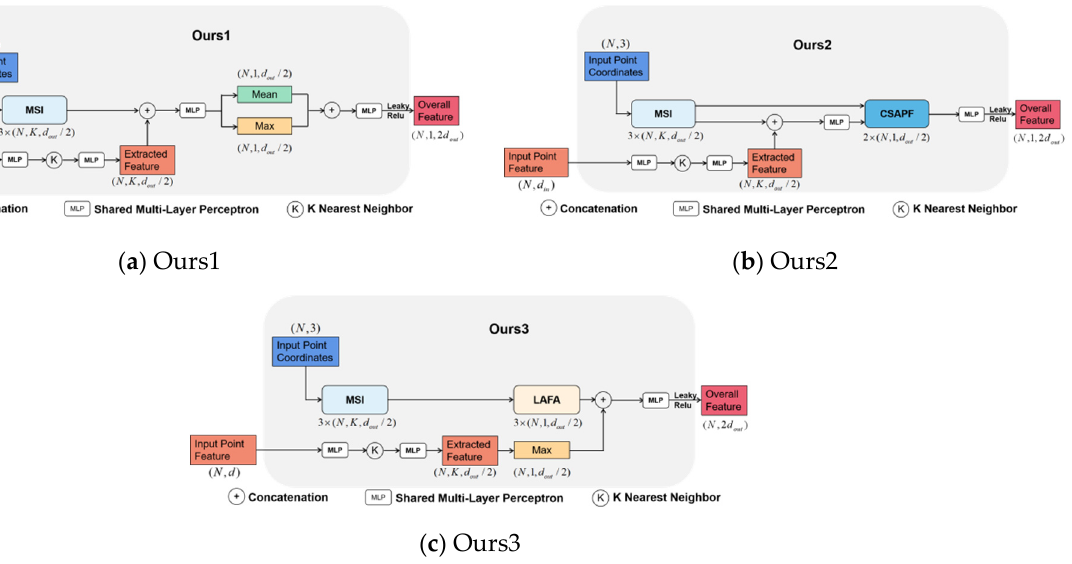
Figure 11. The ablation structures of the MSIDA module. ( a ). Ours1. ( b ). Ours2. ( c ). Ours3. Table 4. The ablation results of the CAPF block and LOFA block.